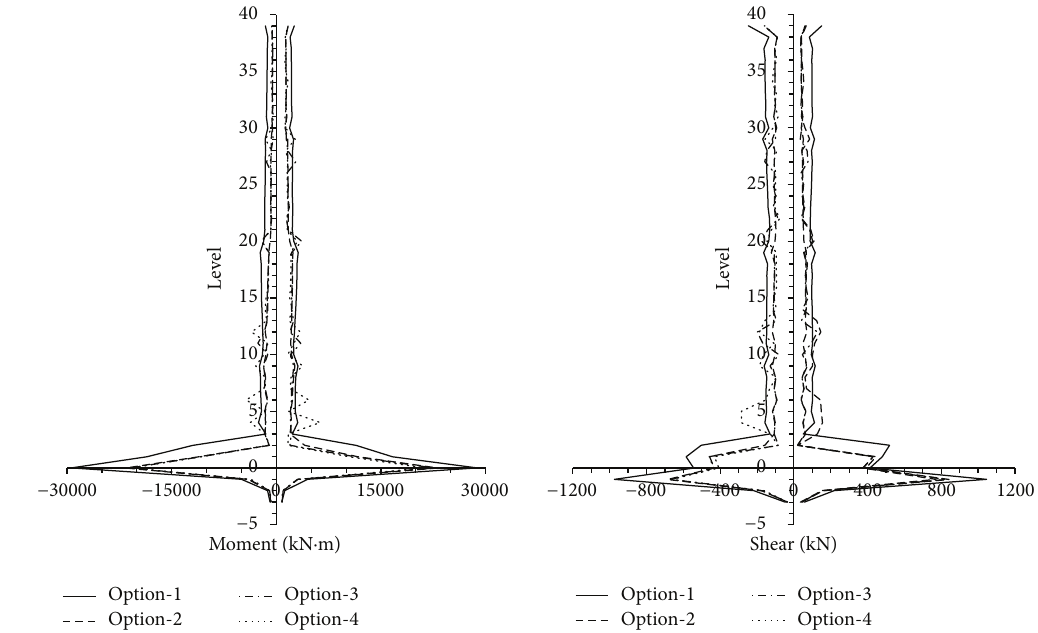
Figure 17: Moment and shear envelope in one typical column.